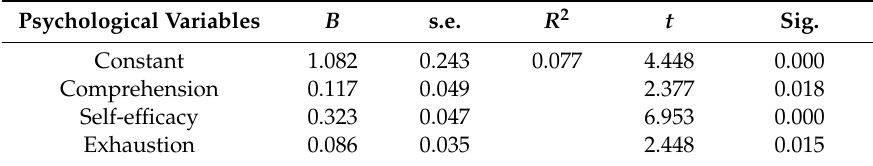
Table 5. Emotional intelligence and academic burnout on goal orientation